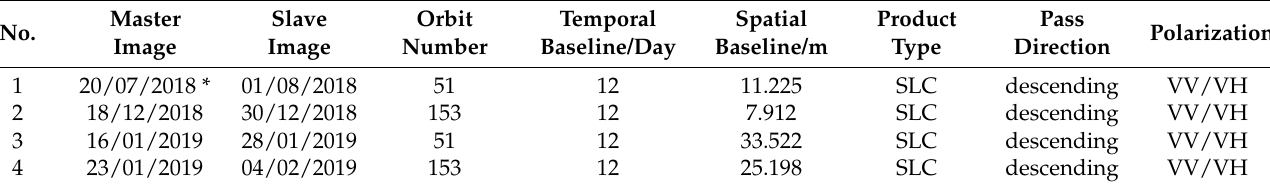
Table 1. Characteristics of Sentinel-1A image